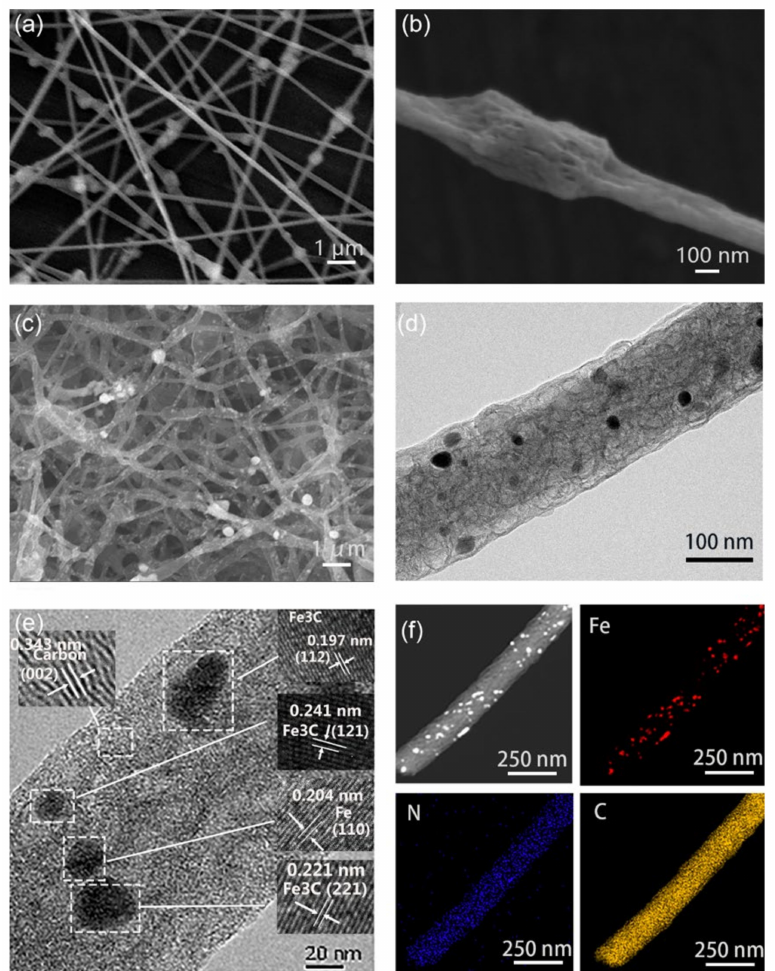
Figure 2. SEM images of (Fe-MIL) 1.5 @PAN nanofiber at a low ( a ) and high ( b ) magnification. ( c ) SEM image of MIL-N-CNF-1.5-800. ( d , e ) TEM images of MIL-N-CNFs-1.5-800. ( f ) TEM images and corresponding EDS elemental mapping of